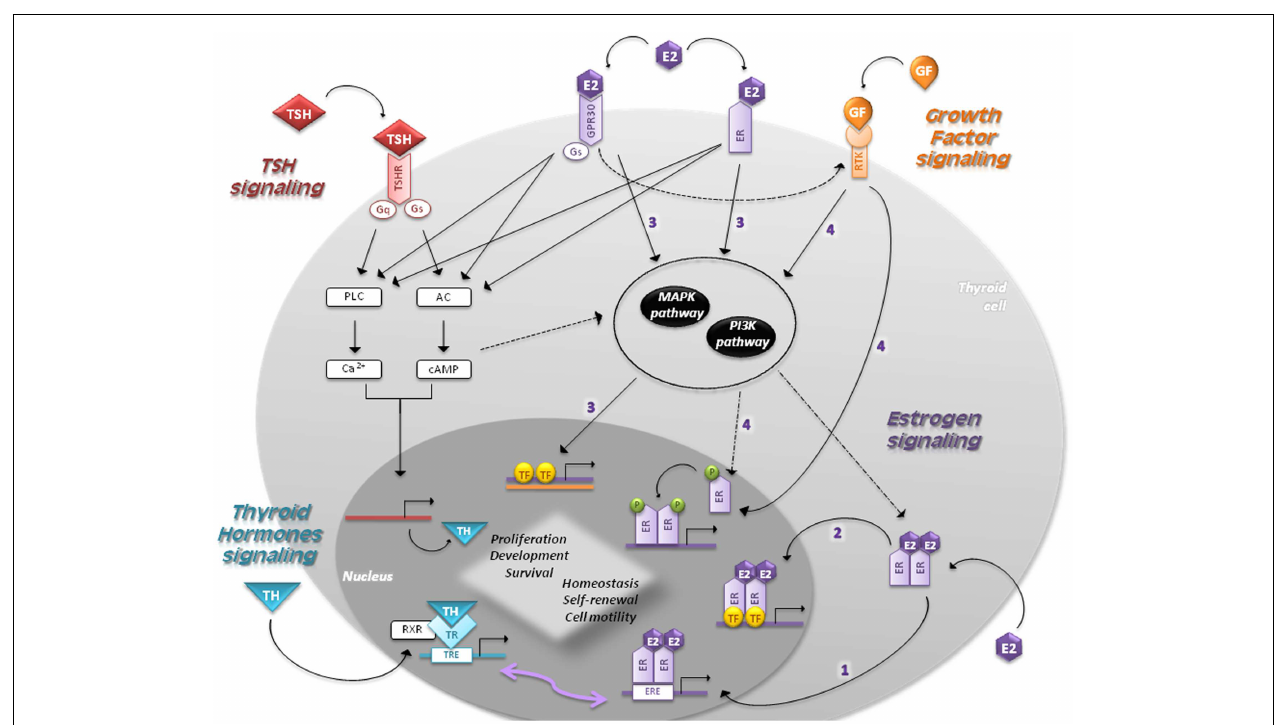
nucleus through protein–protein interactions; (3) non-genomic (or membrane-initiated) estrogen-signaling : E2 activation of plasma membrane-associated ER and GPR30 trigger the activation of MAPK and PI3K pathways and/or increases the Ca 2 + levels; (4) ligand-independent signaling : in absence of E2, GFs can stimulate ERs directly or indirectly through MAPK and/or PI3K pathways.THs play a critical role in development and homeostasis. NuclearTRs activate gene expression by binding to RXR, which in turn bind toTRE-sequences. Given that EREs share a similar nucleotide sequence withTREs, ERs andTRs can interact and regulate several transcriptional responses.The cross-talk between genomic and non-genomic pathways and other integrative signaling lead to a synergic cell